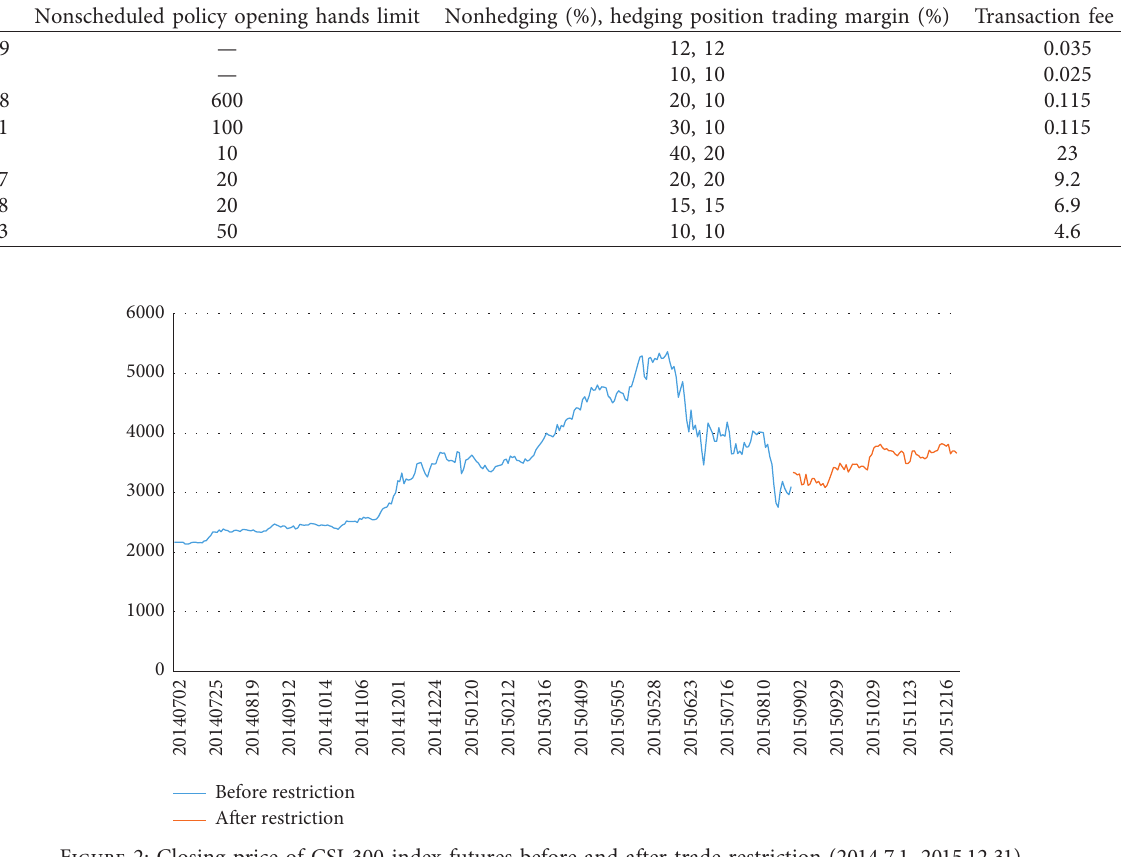
Figure 2: Closing price of CSI 300 index futures before and after trade restriction (2014.7.1–2015.12.31).